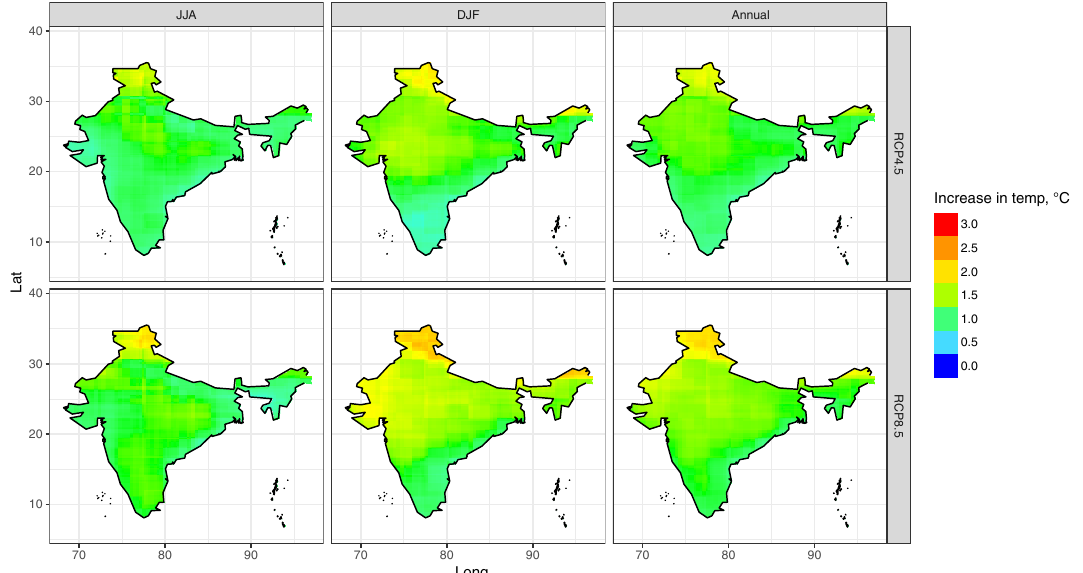
Figure A3. Absolute change ( ◦ C) in the multi-model mean surface air temperature over India between 1975–2005 and 2020–2050. Results are separated under two emission scenarios (RCP4.5 and RCP8.5) and three different timescales: the monsoon period (June–August, JJA), the dry winter period (December–February, DJF) and the annual